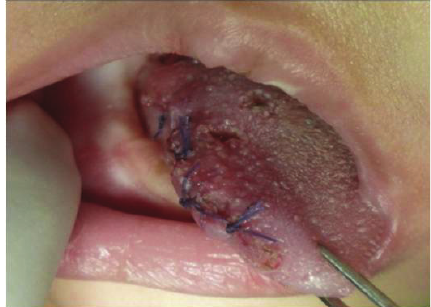
Figure 2: Histopathological characteristics of the vascular leiomy- omas. Microscopically fusiform cell proliferation with elongated nuclei and eosinophilic cytoplasm was observed.